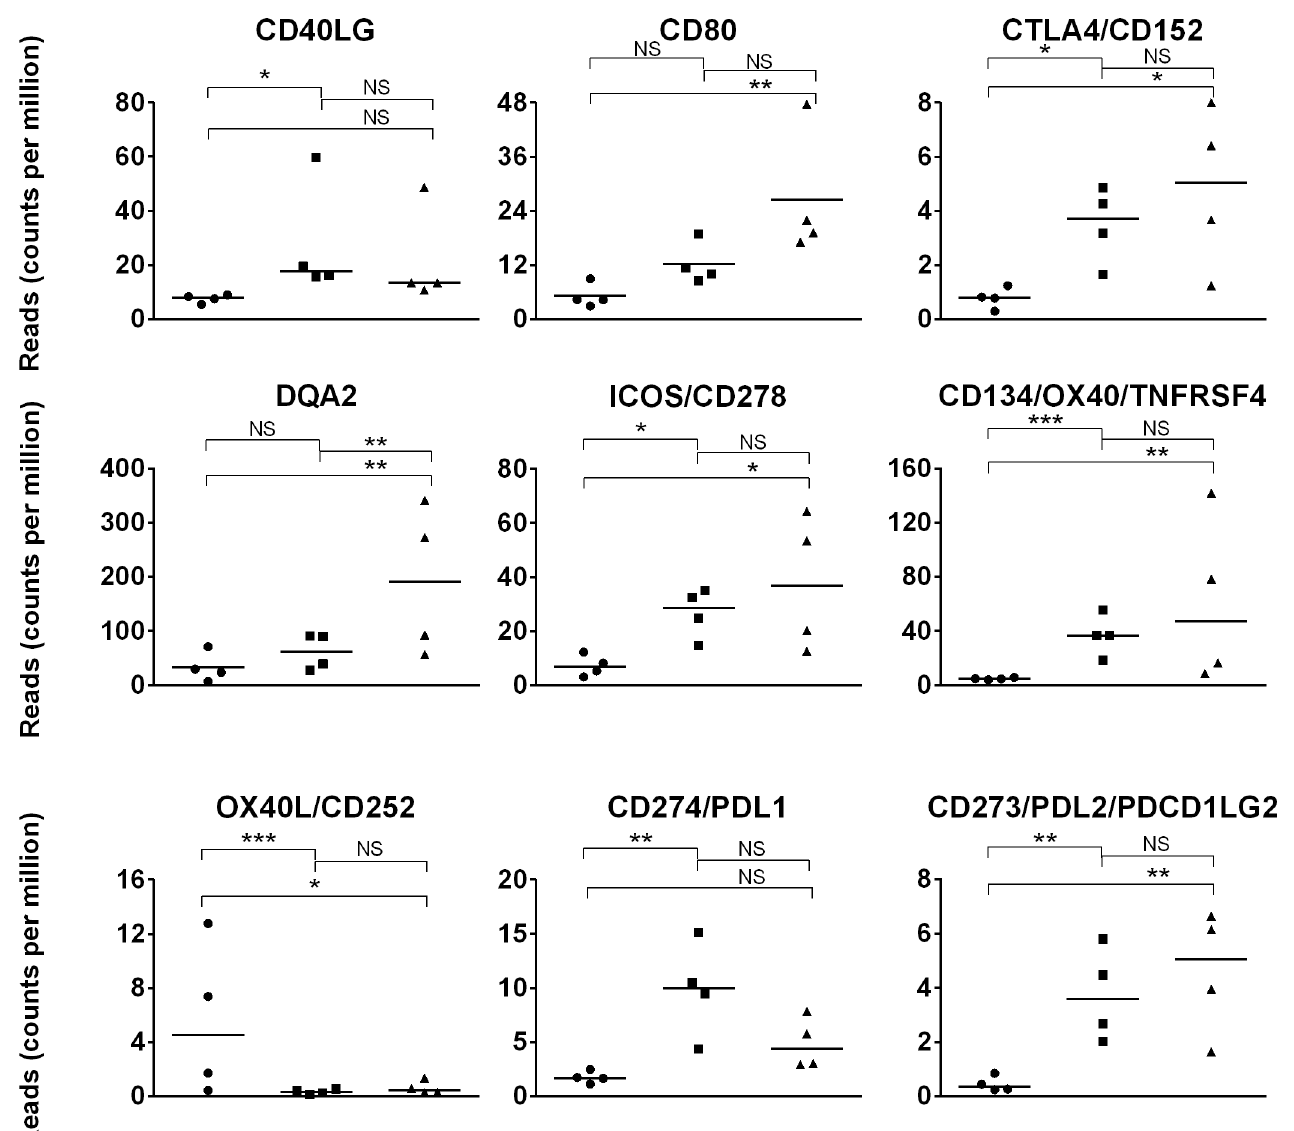
Fig 7. Expression of genes involved in antigen presentation and co-stimulation in day 1 foal, day 42 foal, and adult horse samples. Expression (quantified by number of reads on y-axis) of genes involved in antigen presentation and co-stimulation in day 1 foal (circle), day 42 foal (square), and adult (triangle) samples are plotted on the x-axis. The significance level of comparisons is indicated by asterisks ( (cid:3) p < 0.05; (cid:3)(cid:3) p (cid:20) 0.001; (cid:3)(cid:3)(cid:3) p (cid:20) 0.0001); comparisons that did not differ statistically are labeled “NS” to denote not significant.